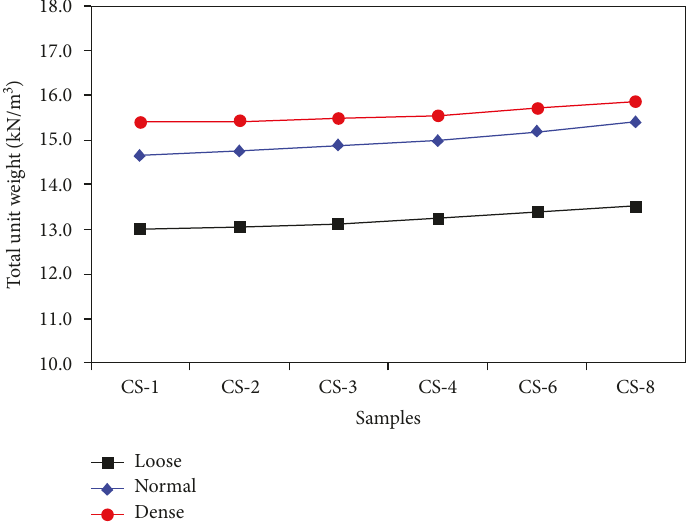
Figure 8: Sample unit weights based on compaction